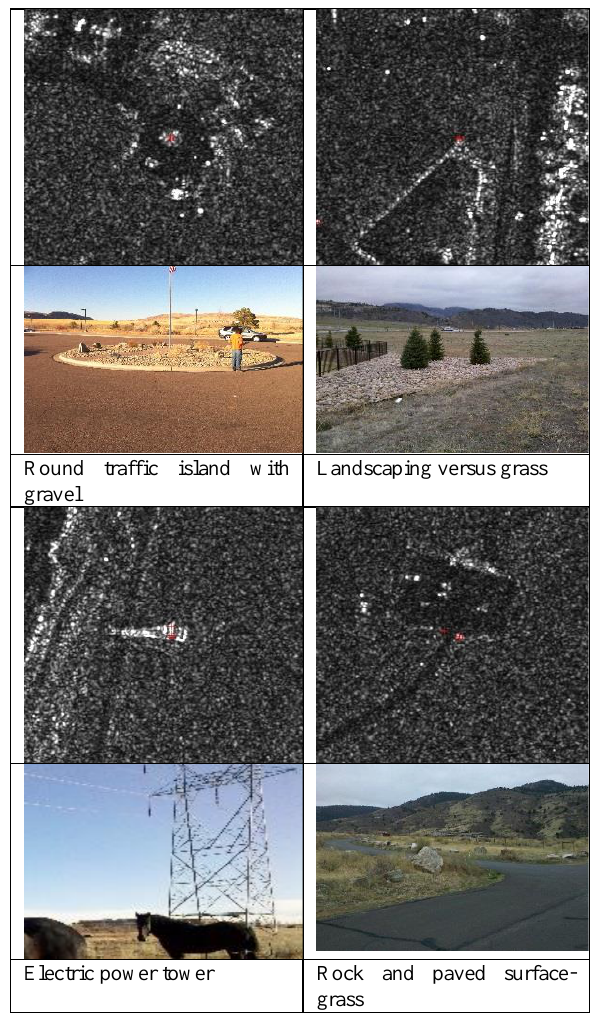
Figure 17. Sample features in SAR data and in the field The right choice of feature provides the optimal result, as mentioned above the right choice is a combination of visibility of one and the same features in the optical image scene and the TerraSar-X dataset.